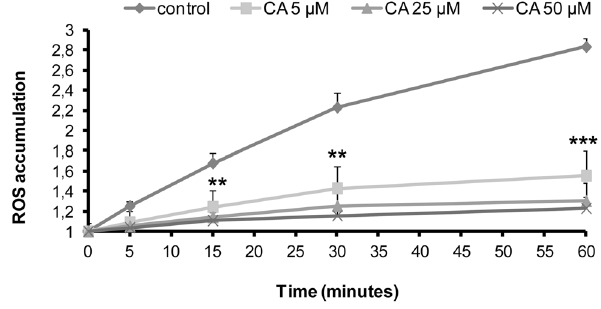
Figure 1. Influence of chicoric acid on ROS accumulation in L6 myotubes. Cells were treated with 5, 25 or 50 m M CA for the indicated times. For each condition, ROS accumulation corresponds to the ratio of the fluorescence measured at the indicated time versus fluorescence at time 0. Values are means 6 SEM (n=3); significantly different from control at ** p , 0.01, ***p ,